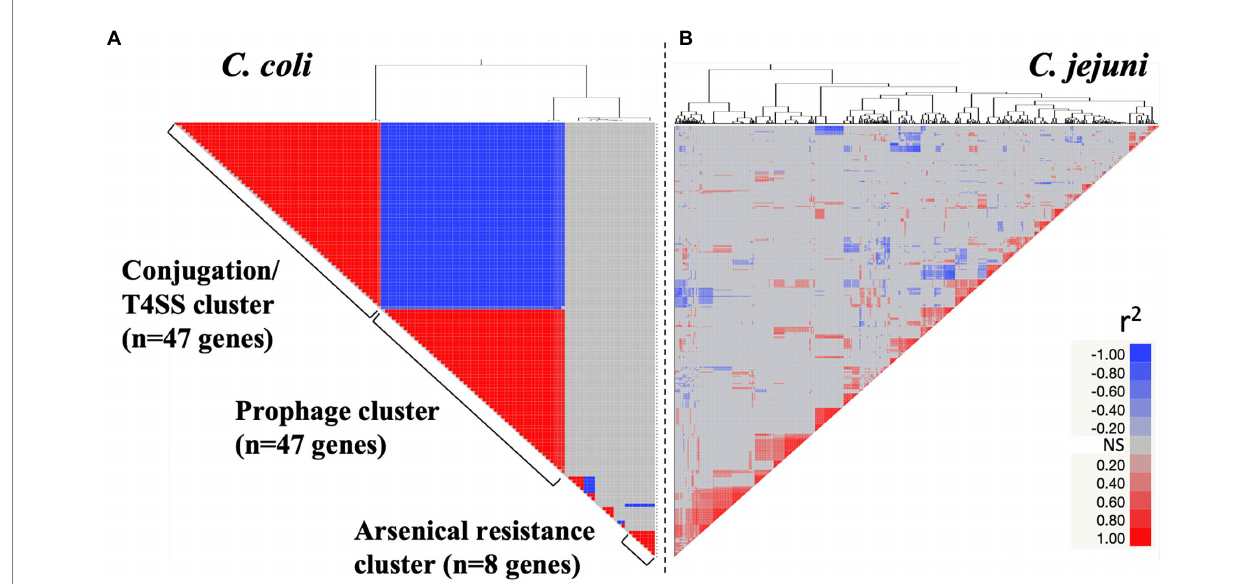
FIGURE 5 Co-occurrence of genes from the variable genome for both Campylobacter coli ( A ; n = 102 genes) and Campylobacter jejuni ( B ; n = 401 genes). X- and Y-axes display the gene co-occurrence profile (r 2 value). Red and blue cells represent positive and negative correlations between genes of the variable genome ( P < 0.01), respectively. Gray cells indicate non-significant correlations (NS; P > 0.01). Details about the gene co-occurrence profile for C. coli are displayed in Supplementary Table